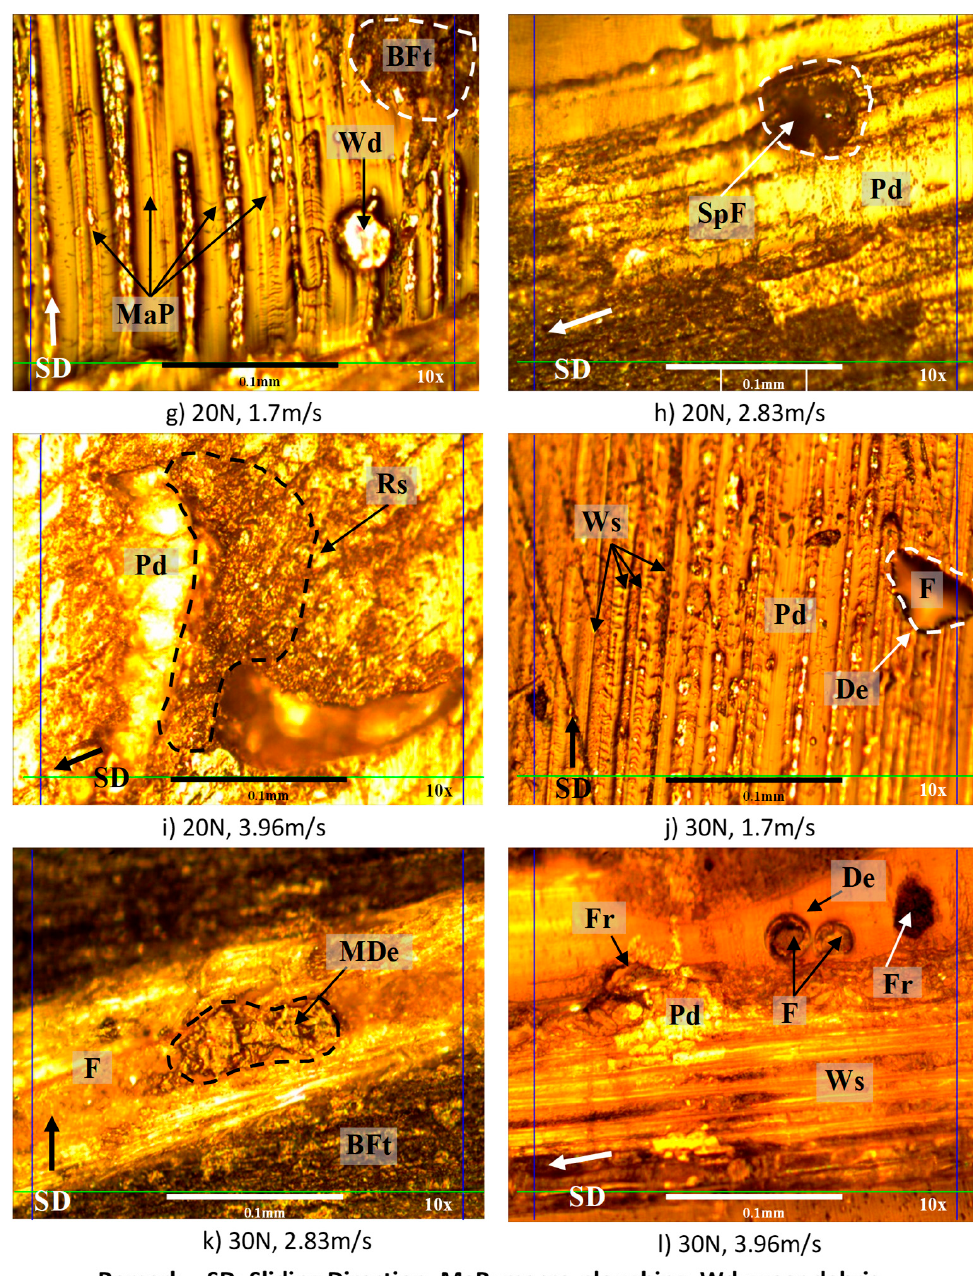
Figure 14. Photo micrographs of BAFRE composite tested in AP-O under different applied normal loads at different counterface sliding velocities .